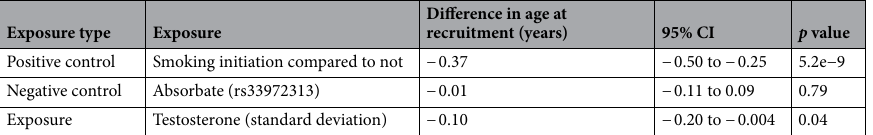
Table 1. Differences in age at recruitment to the UK Biobank for published genetic predictors of testosterone 28 , smoking 29 , and vitamin C (absorbate) 30 using Mendelian Randomization inverse variance weighted